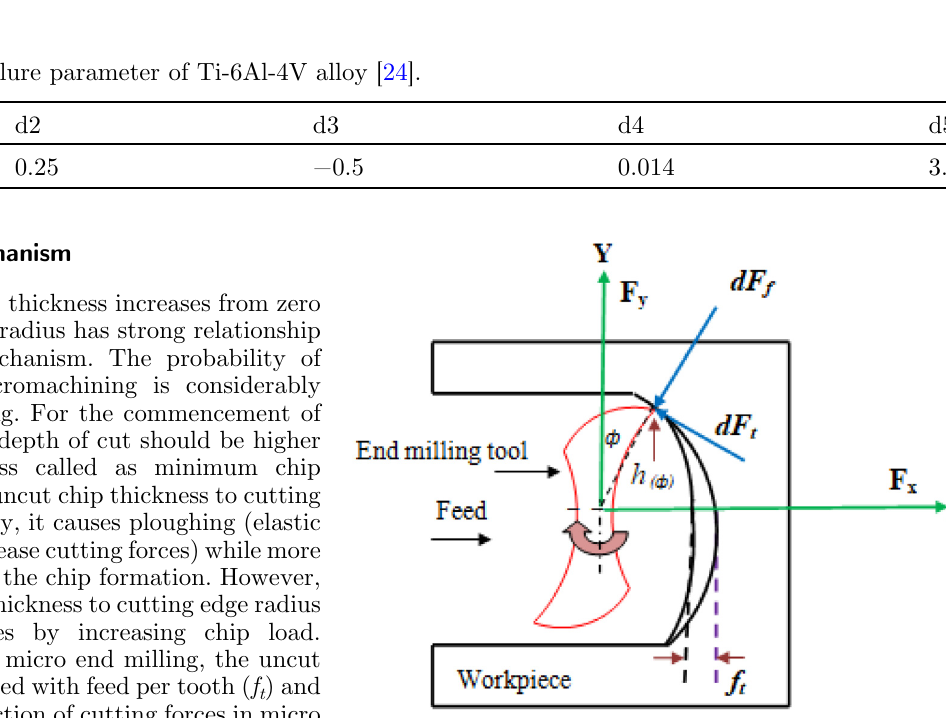
Fig. 3. Micro end milling process with two fl uted end